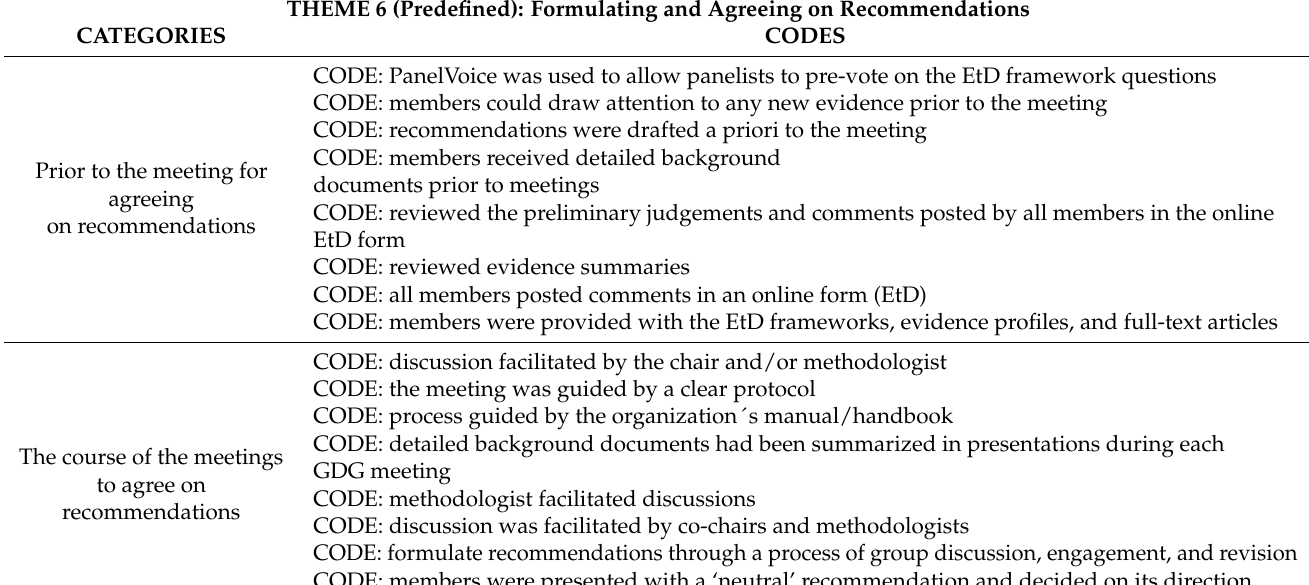
Table 5. Categories and codes for theme